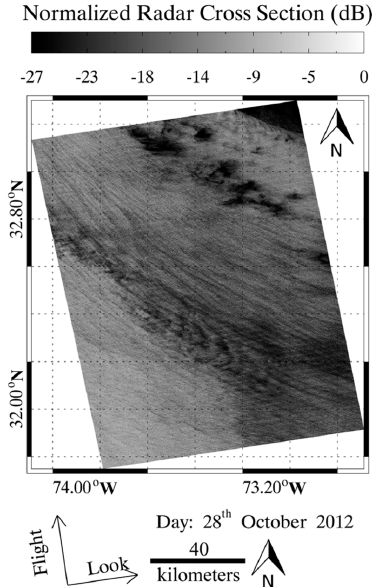
Figure 9. The image of VV-polarization TD-X SAR image in ScanSAR mode acquired over tropical cyclone Sandy at 22:49 UTC on 28 October 2012.